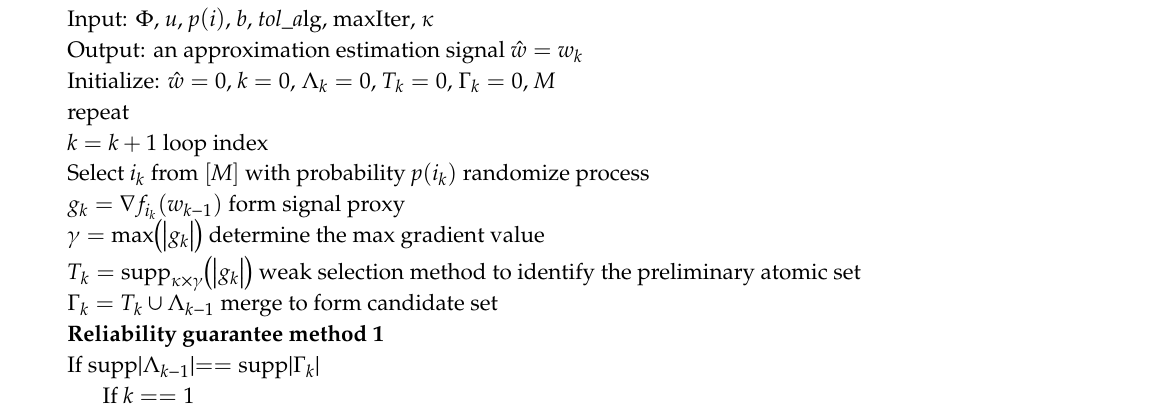
Algorithm 2: Proposed